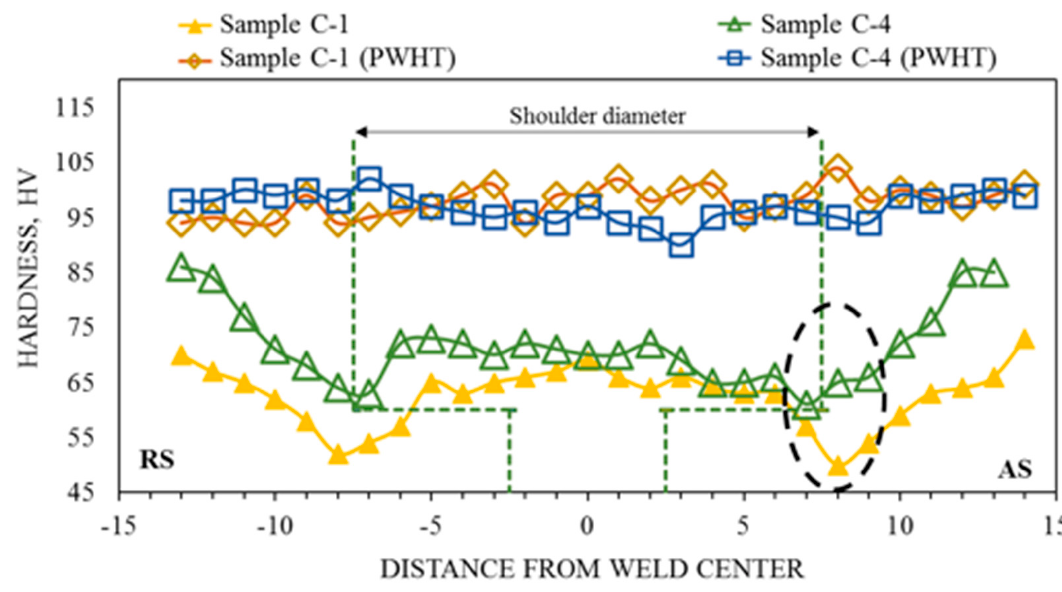
Figure 13. Hardness profile of similar joints of Al6061(T6).